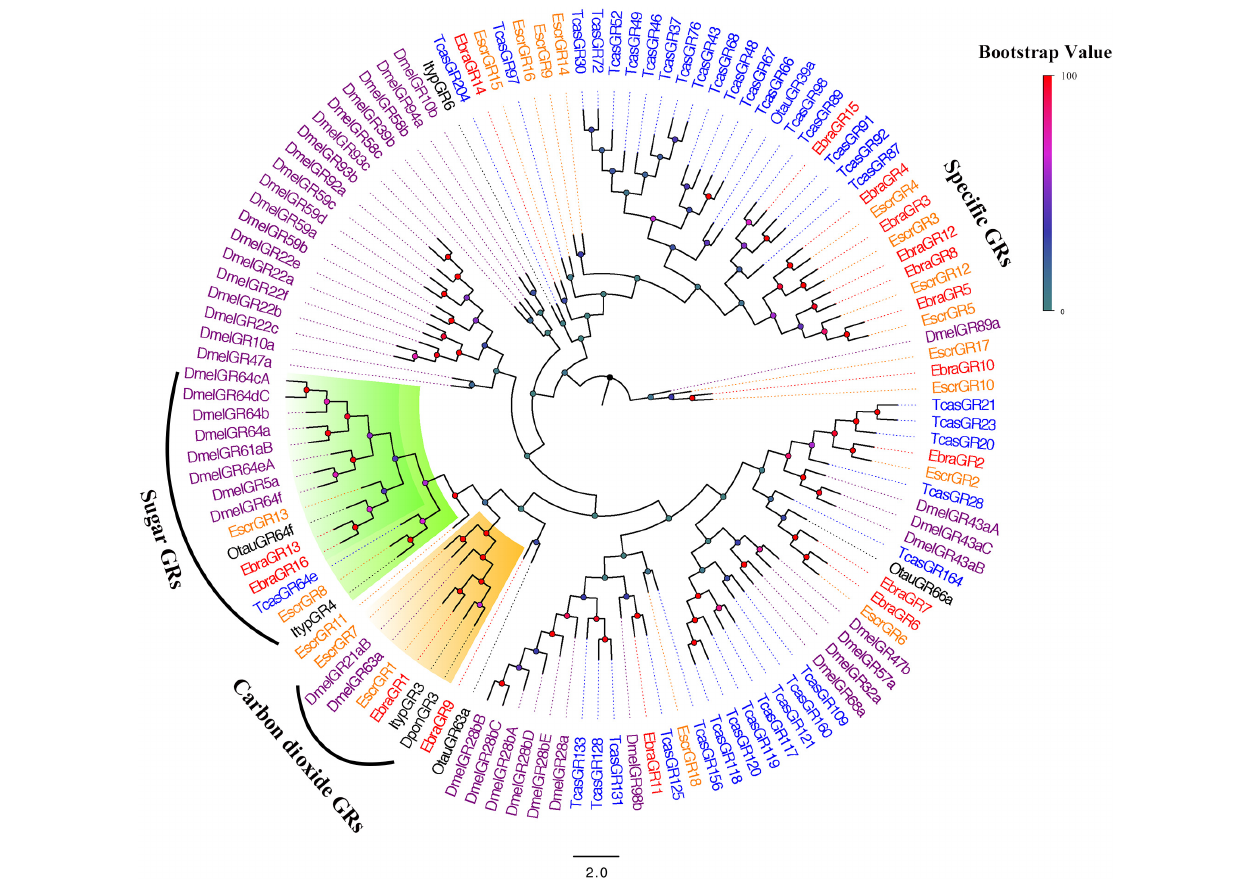
FIGURE 5 | Phylogenetic tree of putative gustatory receptor (GR) genes. The E. scrobiculatus genes are shown in yellow and E. brandti genes are shown in red. The tree was constructed using MEGA6 with Neighbor-joining method. Amino acid sequences used for the tree are listed in Supplementary Table S10